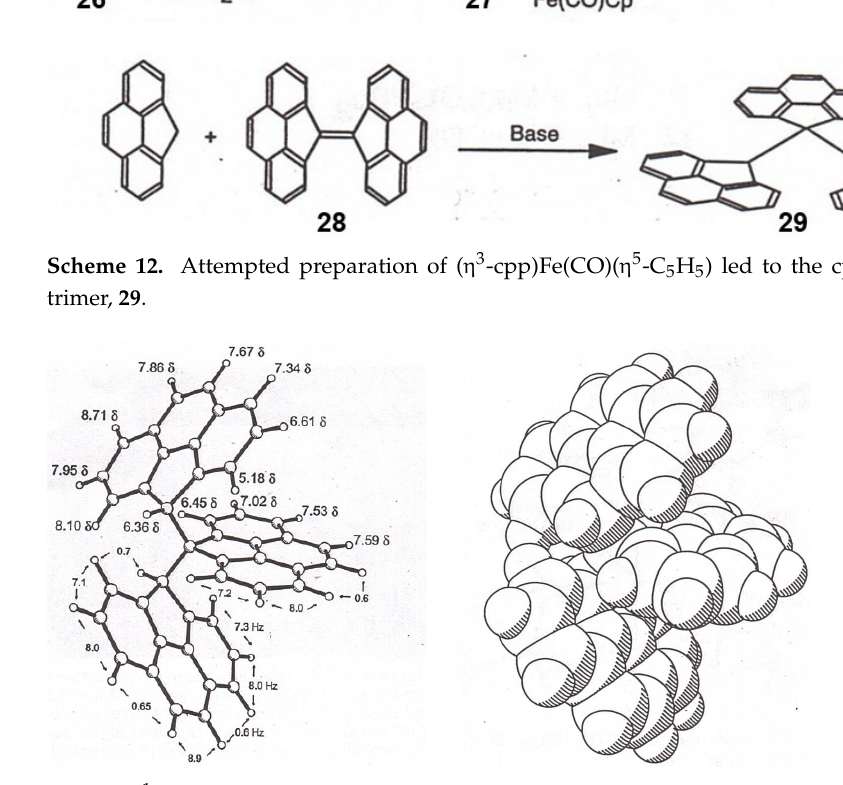
Figure 6. 1 H NMR spectroscopic assignments, and a space-fill view of 29 .